Question: Describe this figure in one sentence.
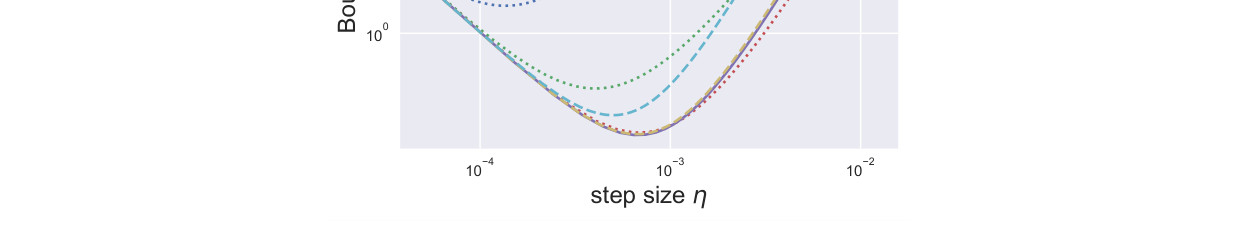
Answer: Variation of the non-convex upper-bound with respect to the step size η, for K = 104 server steps and different values of sampling p. The maximum step size value is different for each case and equal to q